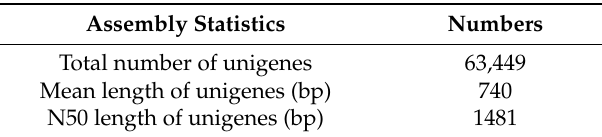
Table 1. Throughput and quality of RNA-seq of the differentially expressed gene libraries. Table 2. Summary of the transcriptome assembly.